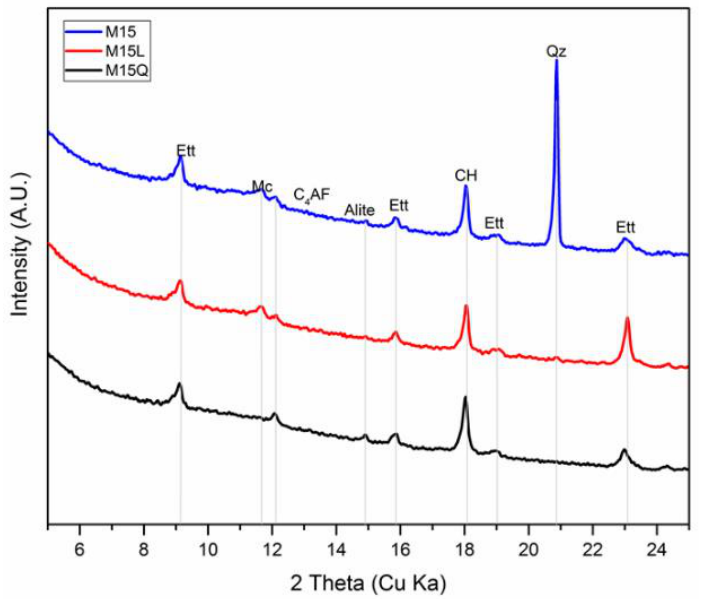
Figure 6. Mineral phases identified by XRD, in the paste fraction of mixtures M15, M15L and M15Q, after 91 days standard curing (ettringite: Ett, monocarbonate: Mc, tricalcium silicate: Alite, tretracalcium ferroaluminate: C4AF, calcium hydroxide: CH, and quartz: Qz).